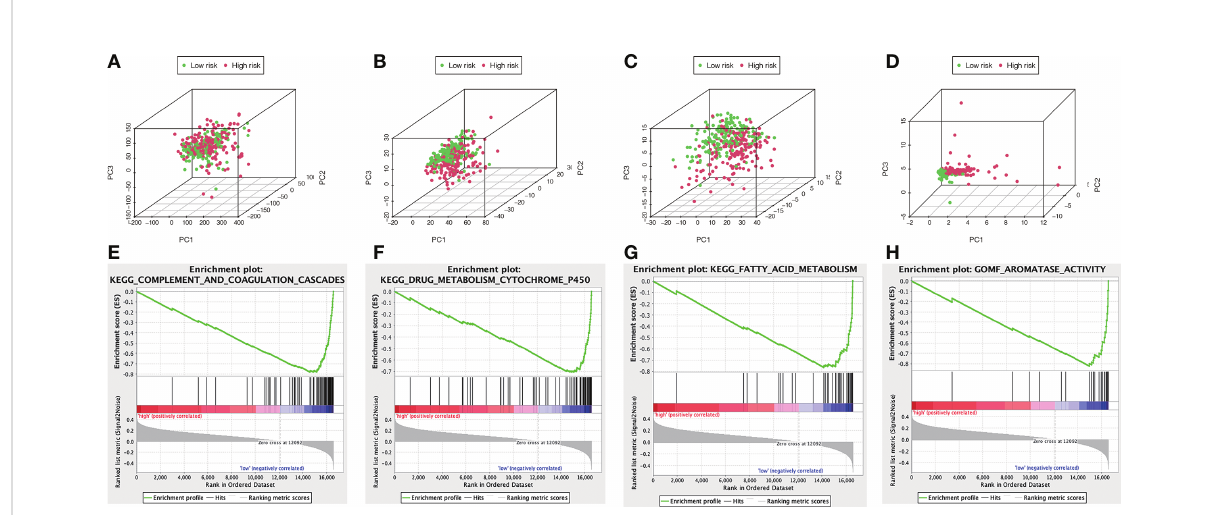
FIGURE 12 The metabolic condition of individuals with high and low risk scores varies. PCA maps depict the allocation of individuals according to the (A) whole genes (B) AME-associated gene sets; (C) AME-associated lncRNAs; and (D) the ALPS. GSEA showed signi fi cant enrichment of the